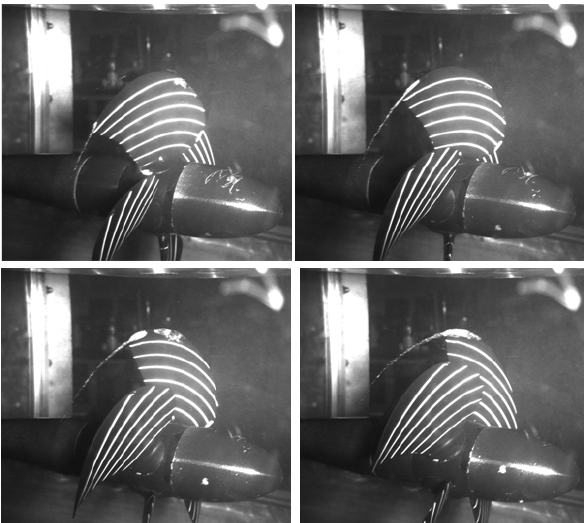
Figure 8: Observed cavity extension in UNIGE cavitation